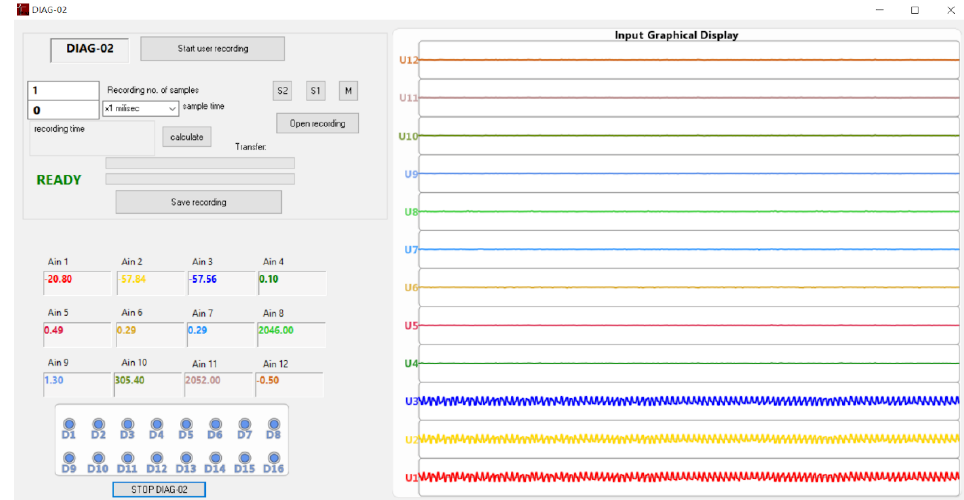
Figure 8. DIAG-02 user interface.